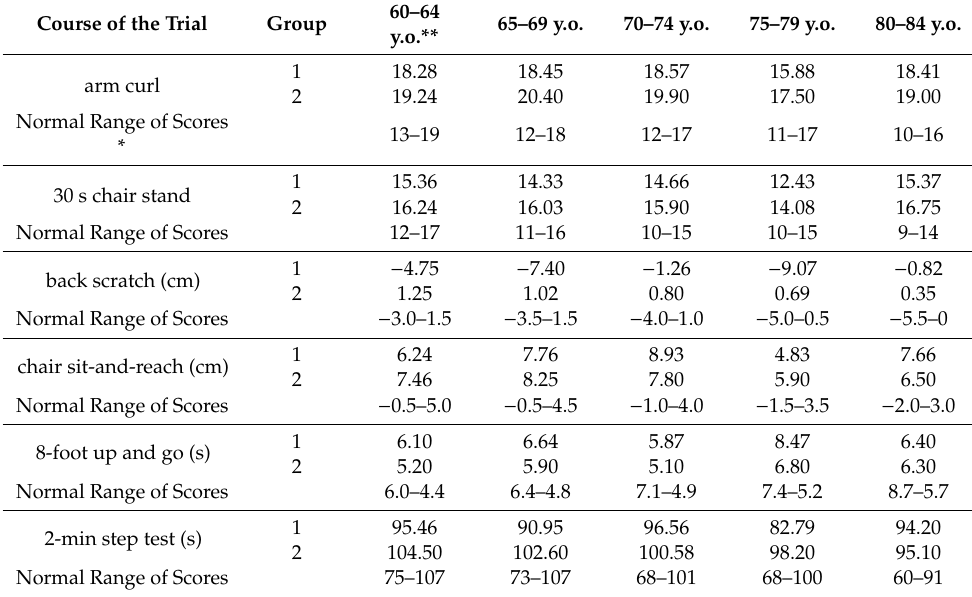
Table 5. Comparison of the level of functional fitness of the examined older adult women in di ff erent age categories with the American